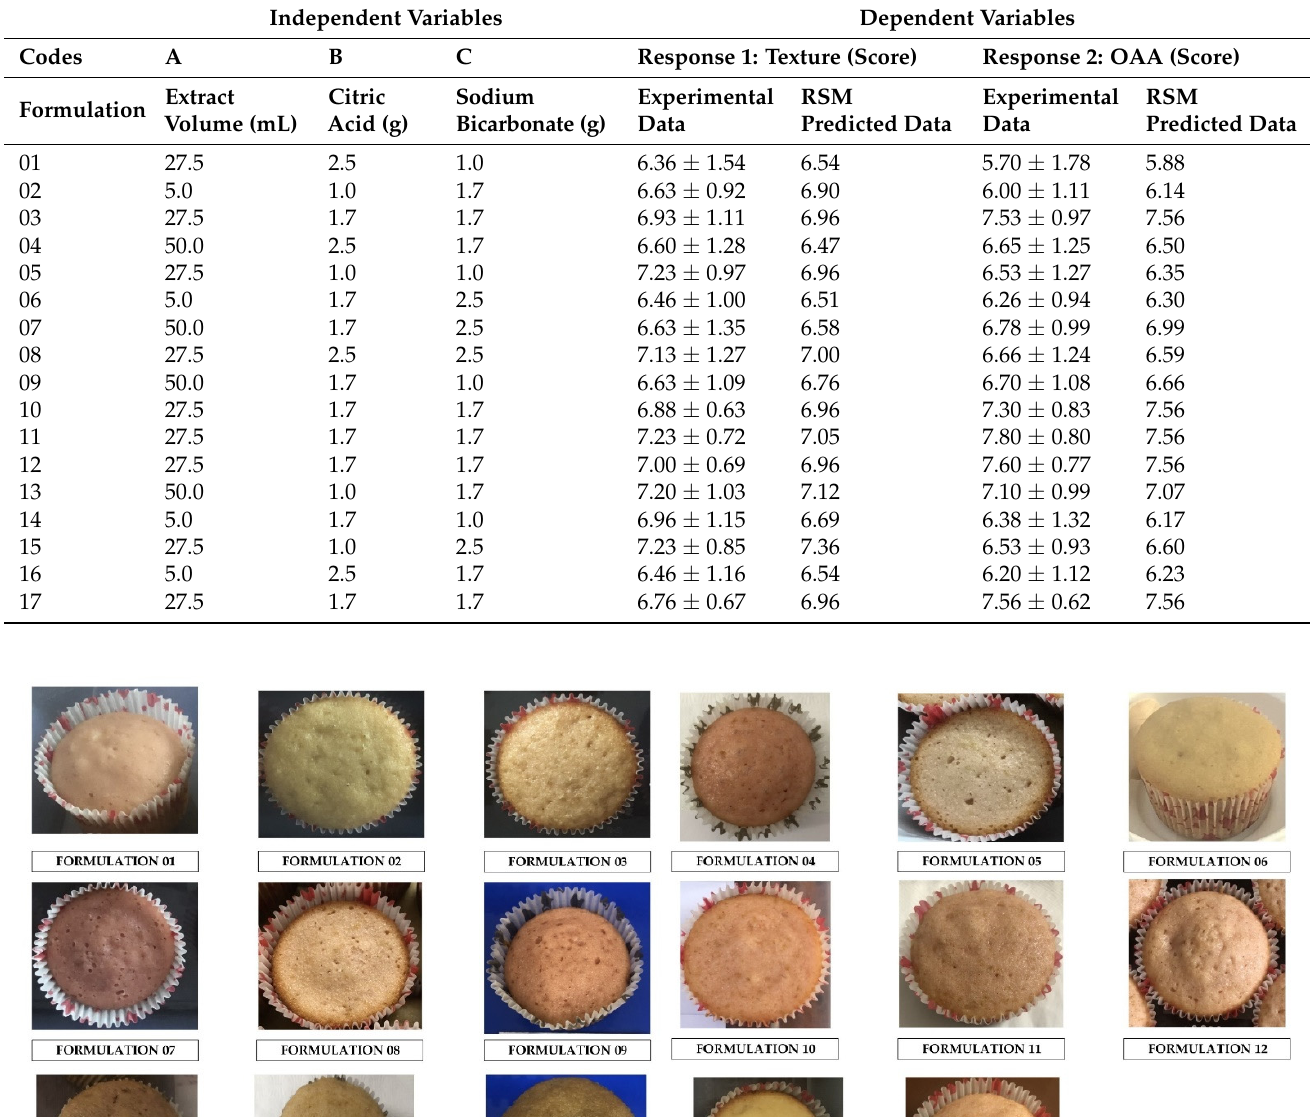
Table 1. Processed data on the muffin score given by the respondents .